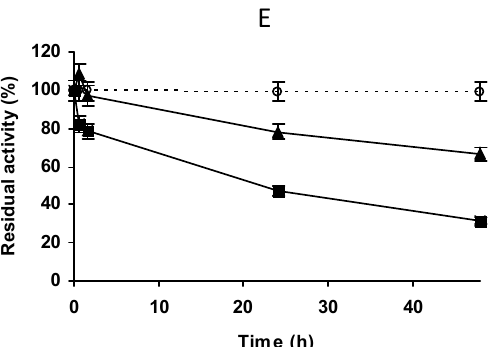
Figure 4. Immobilization courses on glyoxyl agarose ( A ) and on vinyl sulfone agarose at different concentrations of sodium phosphate at pH 8.0, 25 °C. ( B ) 25 mM; ( C ) 250 mM; ( D ) 500 mM; ( E ) 1 M. Empty circles with dashed line: reference suspension. Full triangles with solid line: suspension. Full squares with solid line: supernatant. Other specifications are described in Methods.